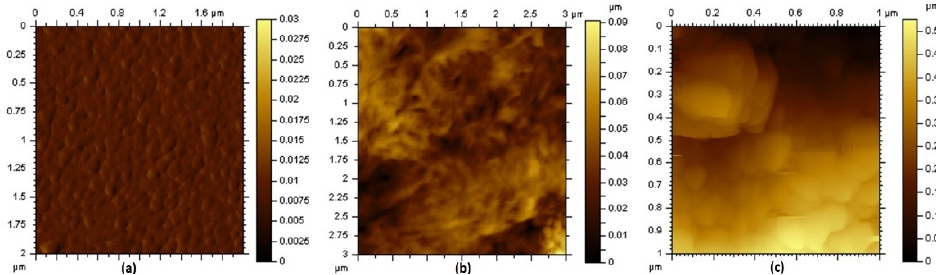
Figure 6. AFM image of ( a ) Al IDTs, ( b ) PVDF film and ( c ) porous graphene/PVDF sensing film.